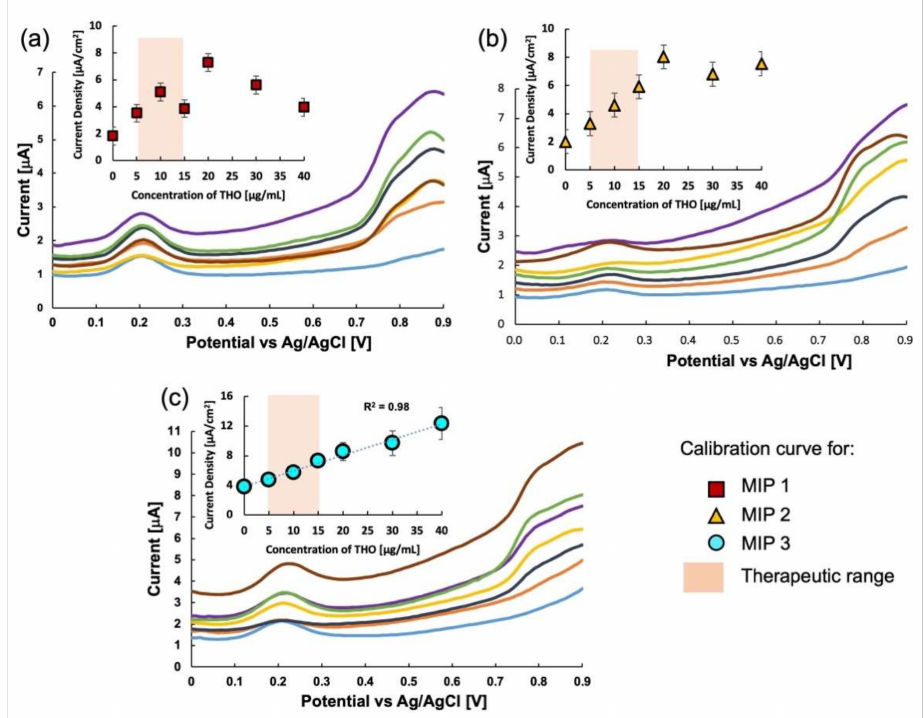
Figure 1. Differential pulse voltammograms showing the response of the three MIP sensors to THO in buffer saline solution of pH 7.4: ( a ) the response of MIP 1 or MBAA-only MIP, ( b ) the response of MIP 2 or EDMA-only MIP, and ( c ) the response of MIP 3 or MBAA+EDMA MIP. The insets of ( a – c ) represent the relationship between the current intensity at 0.8 V and THO concentration.